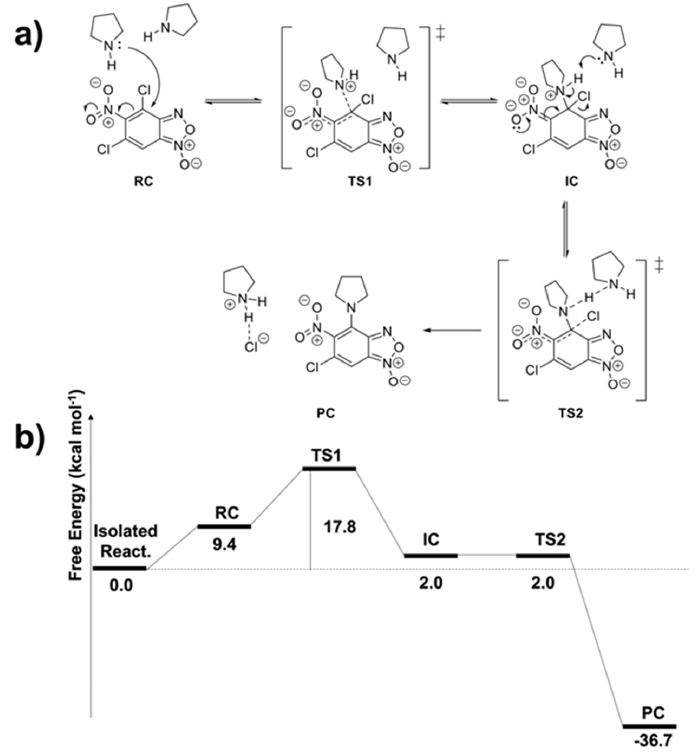
Figure 15. ( a ) Reaction mechanism and ( b ) energy profile (energies in kcal mol − 1 ) of the reactions of 4,6-dichloro-5-nitrobenzofuroxan ( 1 ) with pyrrolidine.